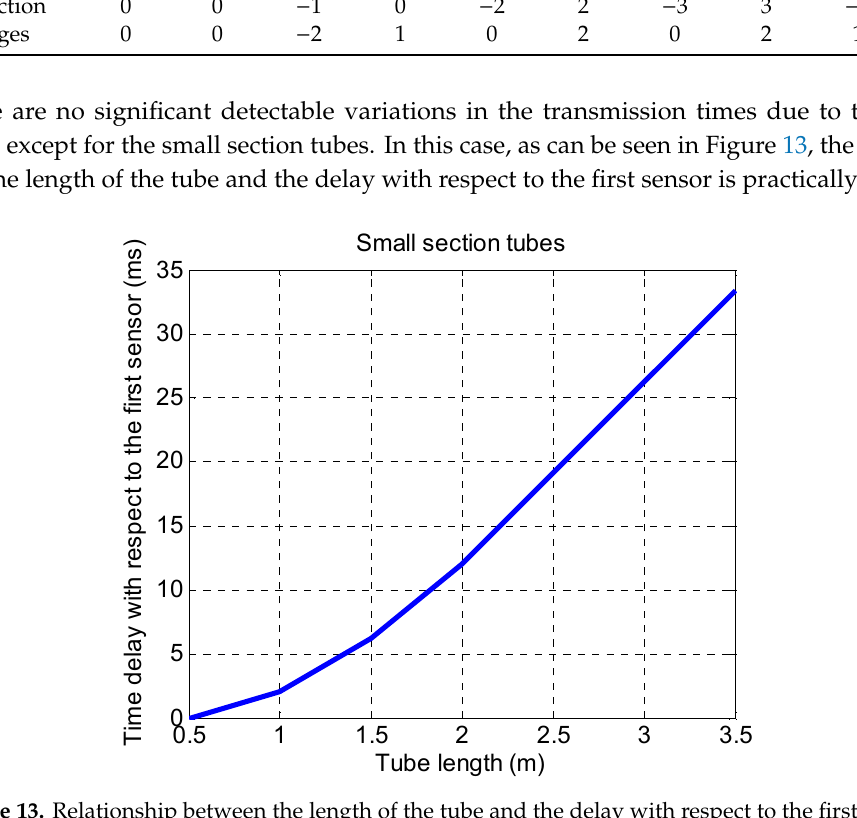
fields are soil fertilization, analysis of permeability, control, and elimination of natural and artificial gas contaminants, like radon. In order to test the system on a real application field, a concrete slab was built over a pressurized air generator system in the soil beneath. This allowed us to provide positive or negative pressurized air into a line under the slab. As shown in Figure 14, works were made in open field, so the system can be used to estimate the movements and flow of underground air. Inner pressure transmission depends on permeability and soil